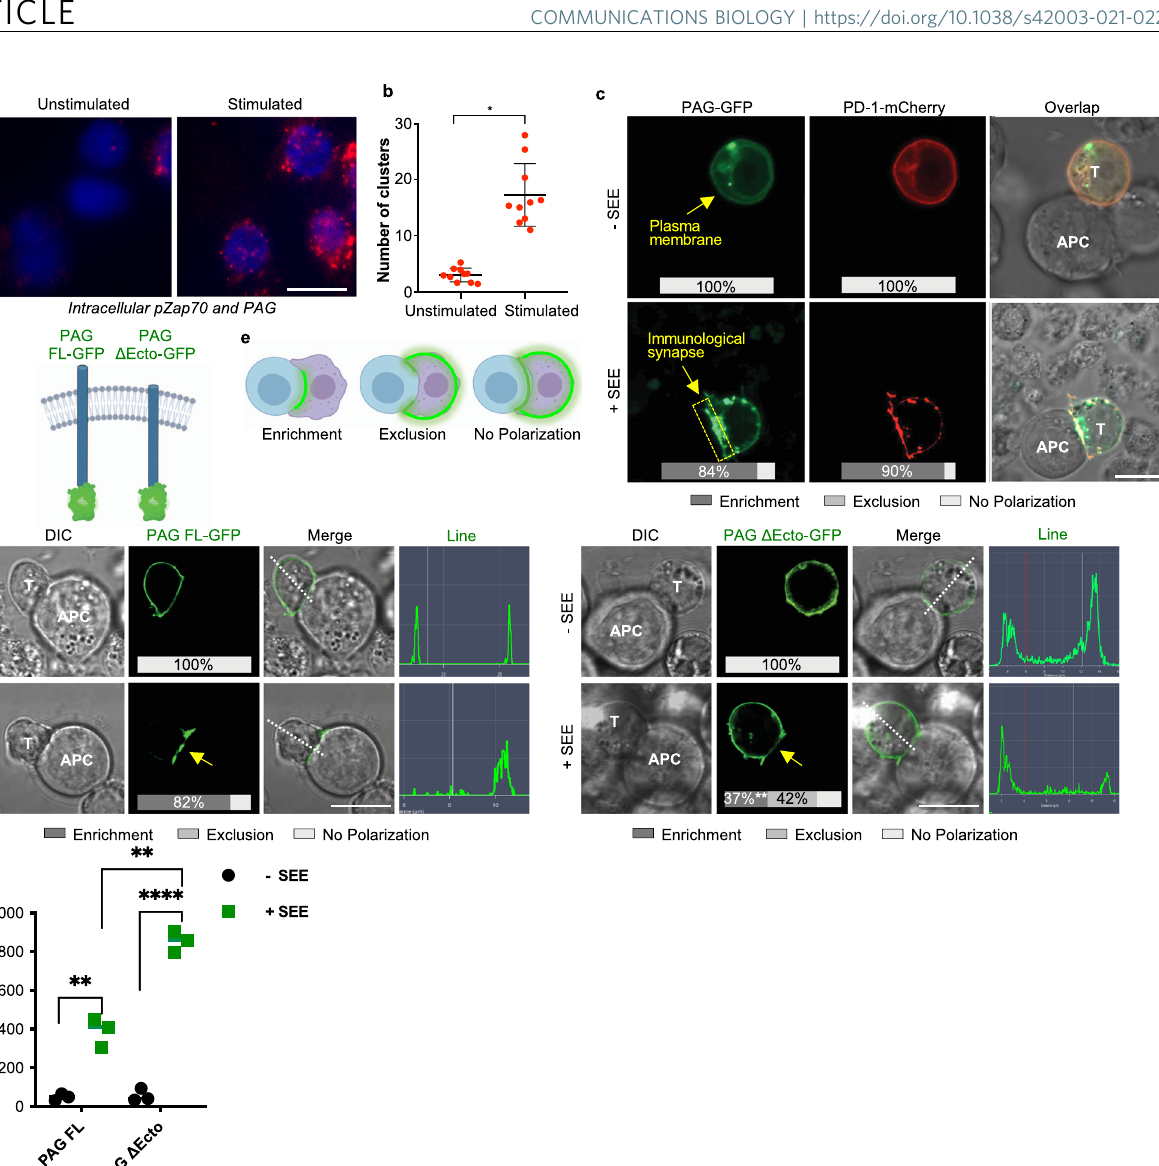
Fig. 4 PAG colocalizes with PD-1 at the immunological synapse. a Jurkat T cells were stimulated with anti-CD3 and microcluster localization of phosphorylated Zap70 and PAG was assessed by the proximity ligation assay. b Quanti fi cation of clusters from the proximity ligation assay ( a ). c Jurkat cells transfected with PAG-GFP and PD-1-mCherry then incubated with Raji cells in the presence or absence of superantigen SEE. Inset percentages represent the percentage of counted cells with the represented phenotype. Fifty cells were counted for each condition in three independent experiments. d Schematic of PAG constructs — full length, wild type PAG (PAG FL); extracellular domain deletion of PAG (PAG Δ Ecto). e Schematic of the characterization of GFP localization. f Jurkat cells transfected with PAG FL-GFP or PAG Δ Ecto-GFP then incubated with Raji cells in the presence or absence of superantigen SEE. Fifty cells were counted for each condition in three independent experiments. Inset percentages represent the percentage of counted cells with the represented phenotype, statistical comparison of % enrichment between PAG FL and PAG Δ Ecto is shown. Dotted white line and histogram show representative line analysis. g ELISA of secreted IL-2 in the supernatant of Jurkat cells transfected with PAG FL or PAG Δ Ecto. Jurkat cells were co- cultured with Raji cells in the presence or absence of superantigen SEE for 24 h prior to supernatant collection. Individual data points shown with median indicated of three independent experiments; scale bars represent 10 µ m. ** p < 0.01; **** p <